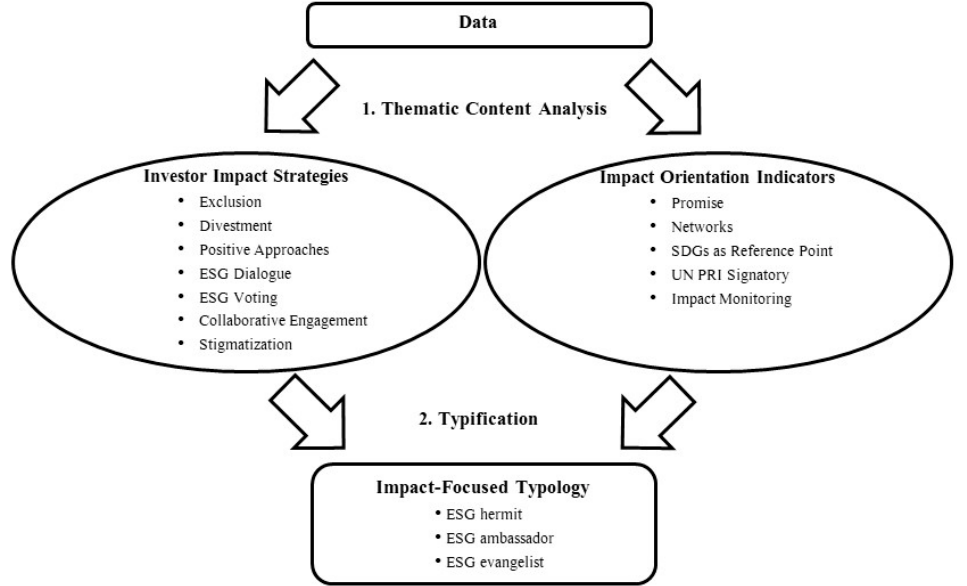
Figure 1. Methodical approach.